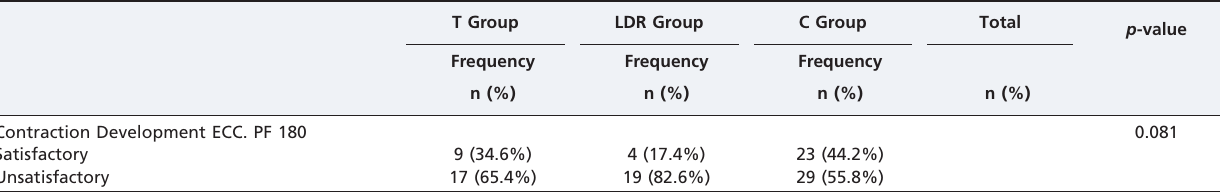
Table 4 - The absolute and relative frequency of the eccentric contraction of the plantar flexors at the 180 ˚ /s velocity of the total sample and the comparison among the triathlete group (TG), long-distance runner group (LDRG), and control